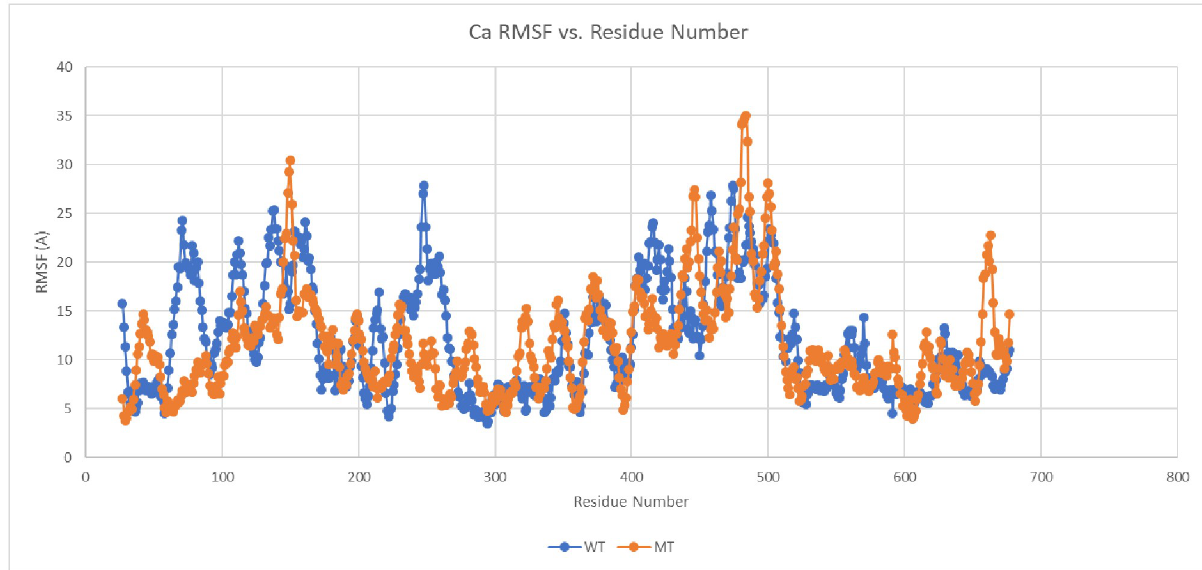
Fig 10. C-alpha (Ca) RMSF values for the S1 segment of the Spike protein over a period of approximately 0.1 μ sec. demonstrating the great degree of flexibility of the Spike protein. Blue—Wild; Orange-Mutant. NTD residues 21-318; RBD residues 319-527: SD1/SD2 residues 533-677.